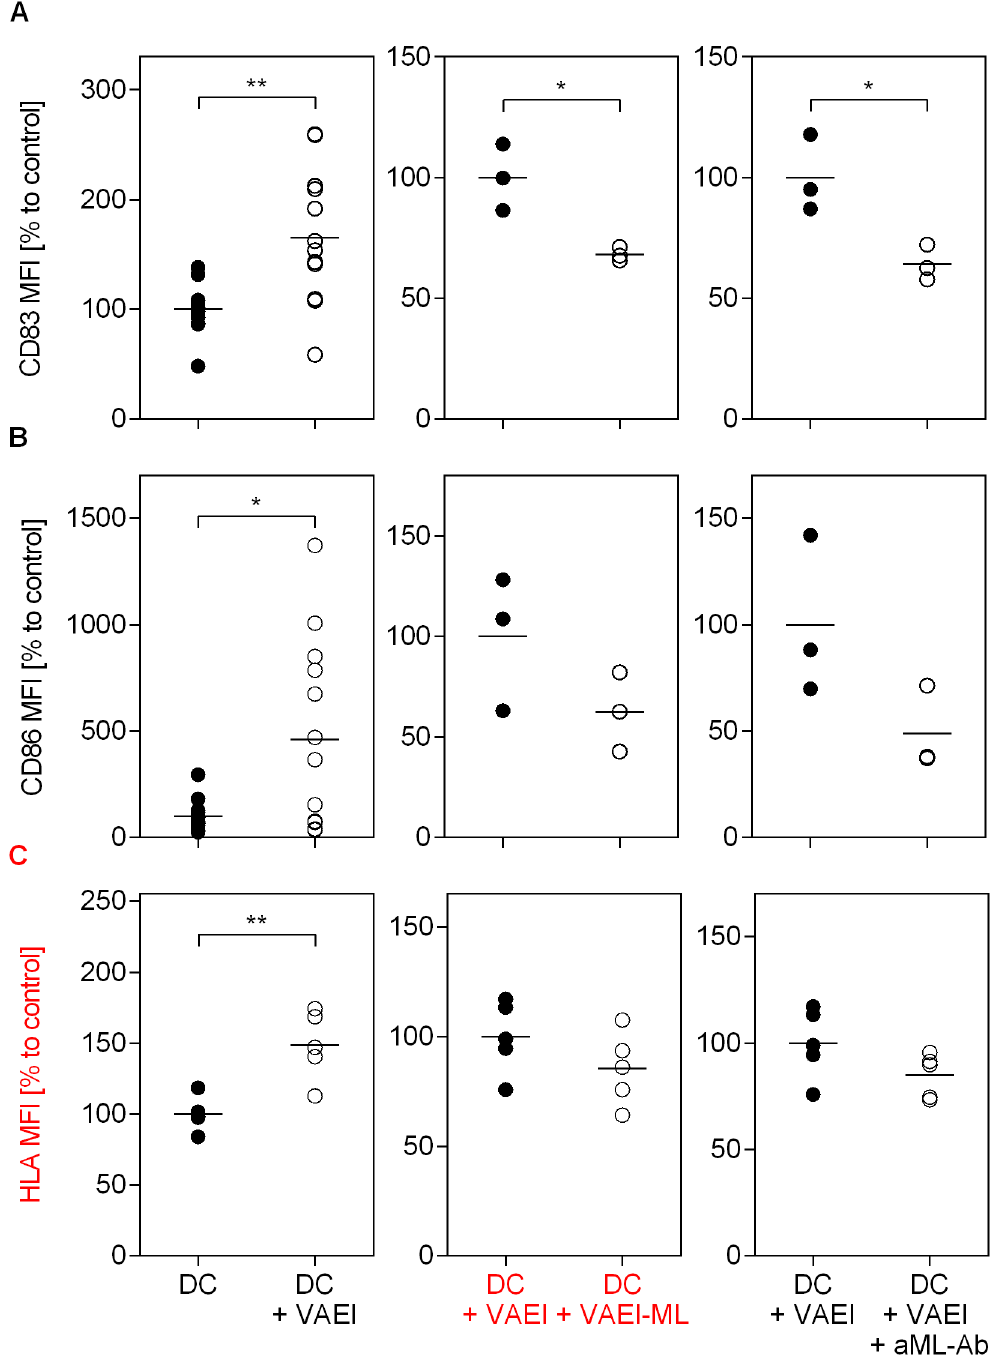
Fig 4. Dependency of VAEI-induced DC maturation on mistletoe lectins. Dendriticcells derived from CD14 + monocytes were culturedin medium alone (DC) or supplemented with VAEI (DC + VAEI; Iscador ® Qu Spez; 0.5 μ g/ml), ML-depletedVAEI (DC + VAEI-ML; Iscador ® ;0.66 μ g/ml) or VAEI and anti-ML antibody (DC + VAEI + aML-Ab). DC maturation was assessed by flow cytometric analysisof CD83 (A) , CD86 (B) and HLA-DR (C) expression. MFI = Mean fluorescence intensity. Data and mean of 13 (DC + VAEI; CD83 and CD86), 3 (DC + VAEI-ML and DC + VAEI + aML-Ab; CD83 and CD86) or 5 (HLA-DR) individualexperiments are representedin relationto untreatedcells (DC = 100%) or VAEI-treated DC (DC + VAEI = 100%). Asterisks indicatesignificant differences betweenthe groups ( * P < 0.05, ** P < 0.01, *** P < 0.001).